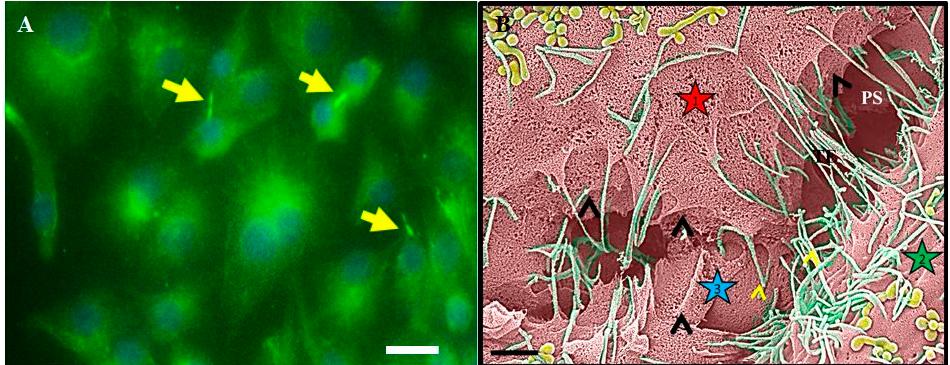
Figure 7. The cytoarchitectural organization of primordial cytoplasmic projections. ( A ) The formation of TENT extensions by cytoplasmic extension of α -tubulin in BEC bEnd5 cells, from the BEC leading membranous edges. The yellow arrows indicate TENT extensions, scale bar 20 µm [66]. ( B ) TENT formation on the apico-lateral surfaces of the BEC bEnd5 plasma membrane [31]. PS denotes the paracellular space; the stars represent cells 1, 2 and 3. The black arrows indicate areas of continuous membrane leading edges of BECs, governed by cytoplasmic projections, which develop into thin rope-like tethers. Scale bar 1000 nm.